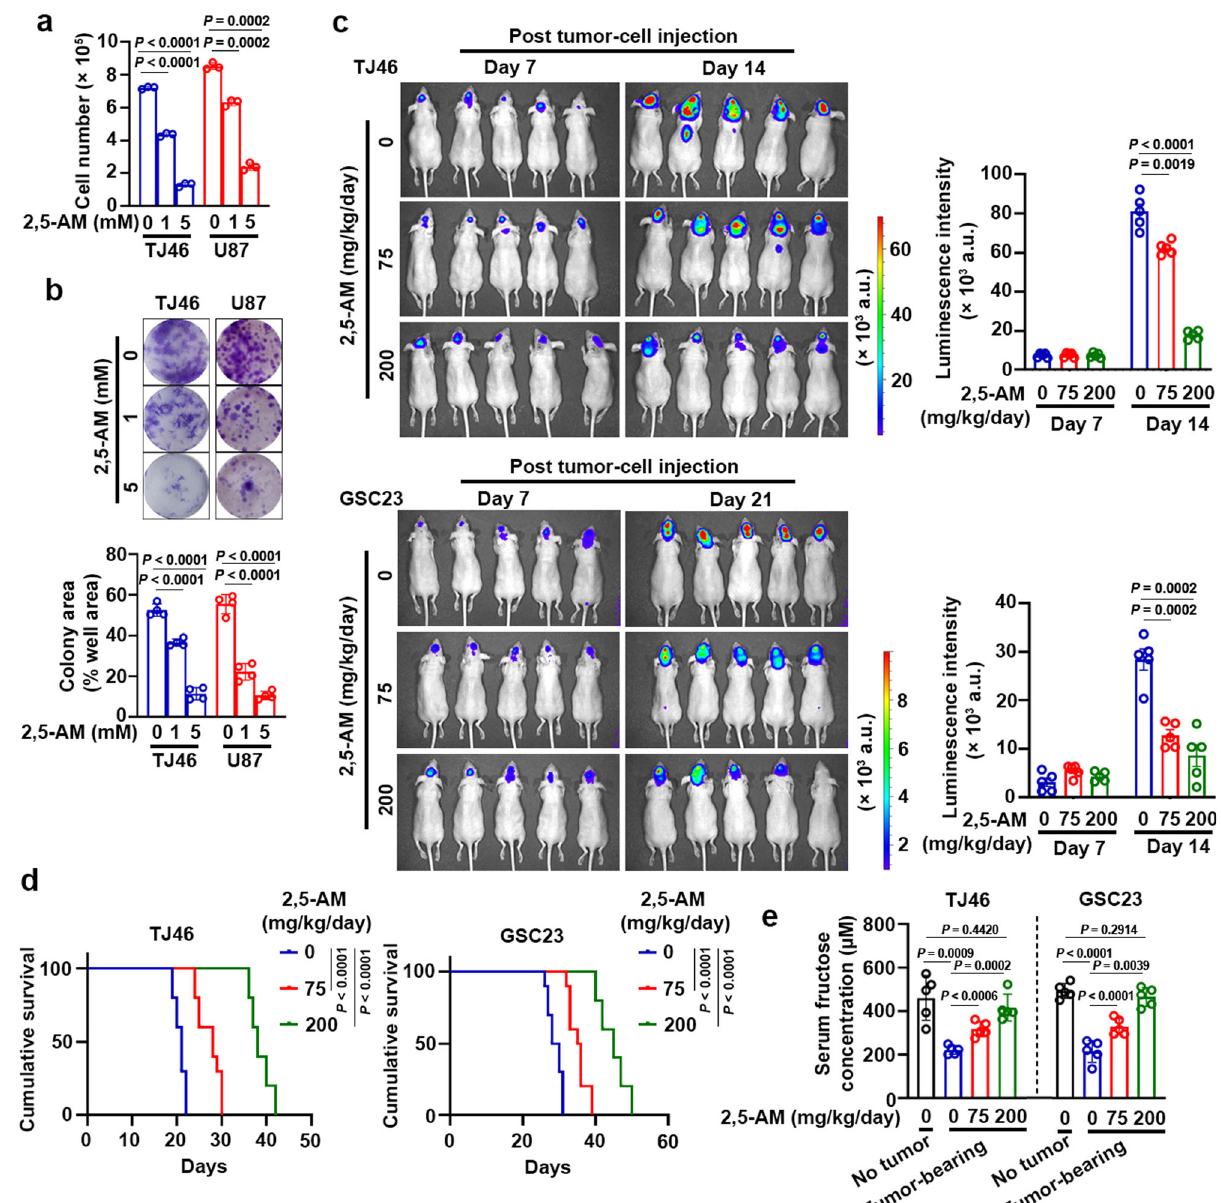
Fig. 5 | Pharmacological blockage of fructose utilization suppresses fructose- induced proliferation and colony formation of GBM cells in vitro and shows therapeutic potential in vivo. a , b TJ46 and U87 cells cultured under glucose- deprived condition supplemented with 10mM of fructose were treated with the indicatedconcentrationoffructoseanalog2,5-AMfor3( a )or14( b )days,andthen collectedandcounted( a )or fi xedby4%paraformaldehydeandstainedwithcrystal violet for colony formation analysis ( b ). c Luciferase-expressing TJ46 and GSC23 cells were intracranially injected into athymic nude mice ( n =5). Seven days after tumor-cell injection, 200 µ l of 2,5-AM (75 or 200mgkg – 1 ) or vehicle (PBS) was delivered to the mice via intraperitoneal administration daily for 7 days for TJ46 cells or 14 days for GSC23 cells. Luminescence intensity derived from tumors was measured at indicated time points post tumor-cell injection and relative lumines- cence intensity is shown. a.u., arbitrary unit. d Luciferase-expressing TJ46